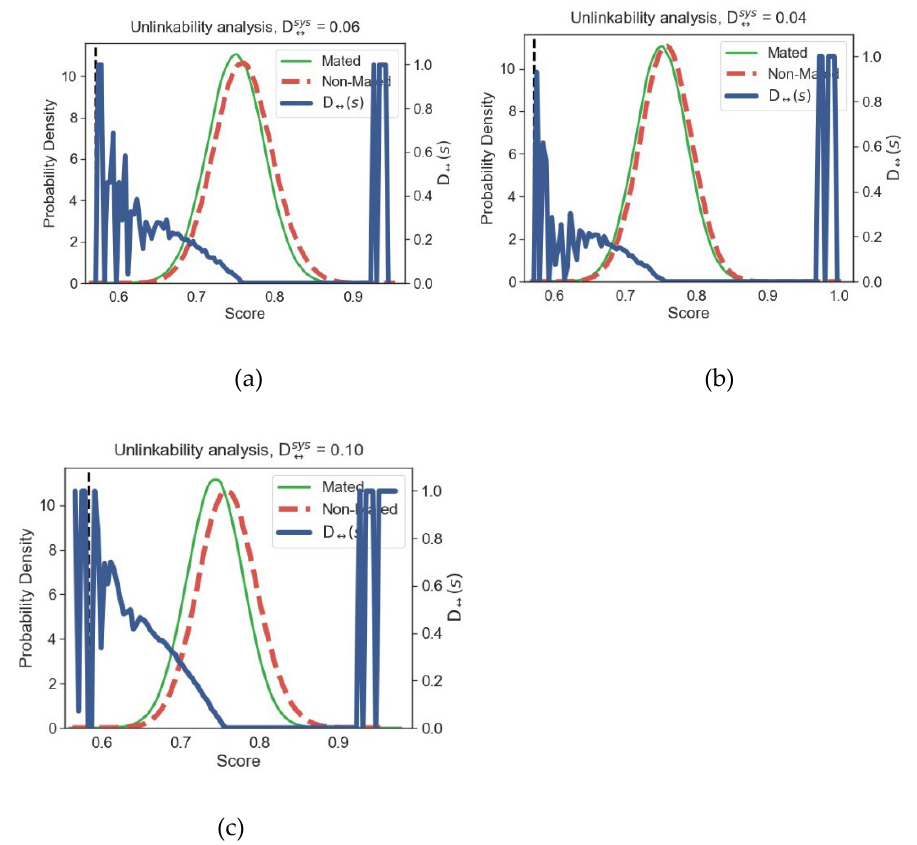
Figure 10. Unlinkability results for the proposed method on the ( a ) Pubfig, ( b ) Facescrub, and ( c ) YTF datasets.